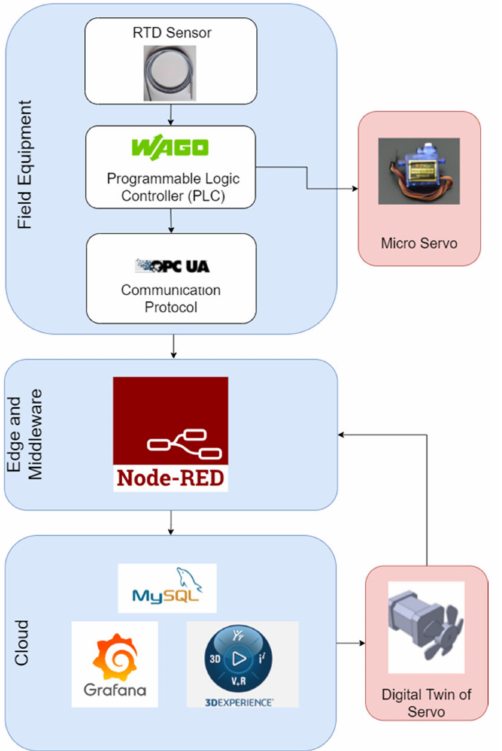
Figure 2. An experimental communication framework to demonstrate data connectivity between the physical asset and digital twin